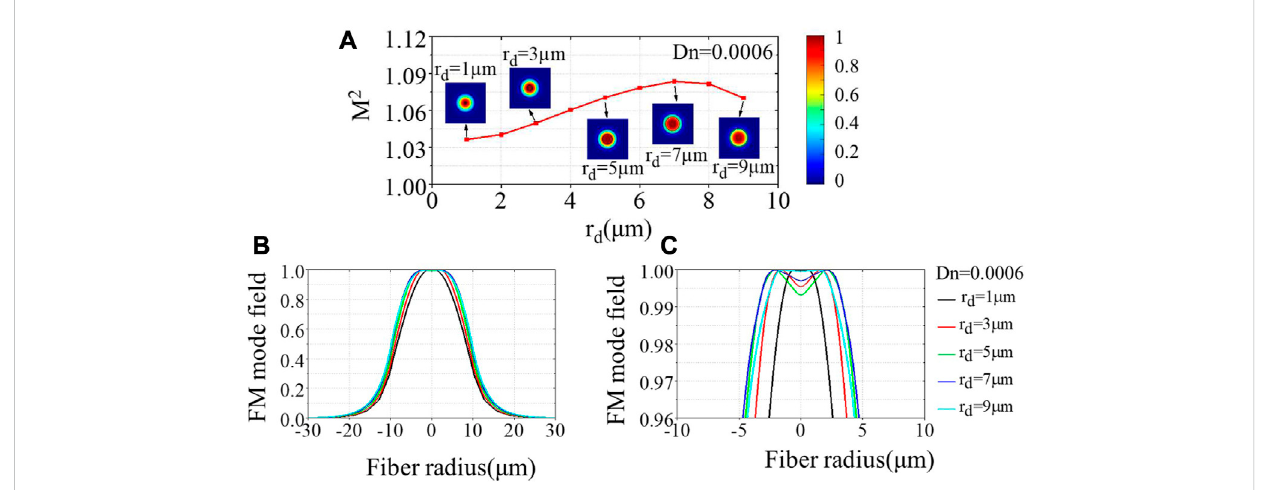
FIGURE 5 (A) Theoretical calculated beam quality M 2 under different dip radii. Insets show the 2D fi eld intensity distribution. (B) Evolution of fi eld distribution under different dip radii. (C) Magni fi ed fi eld distribution in fi ber core under different dip radii.